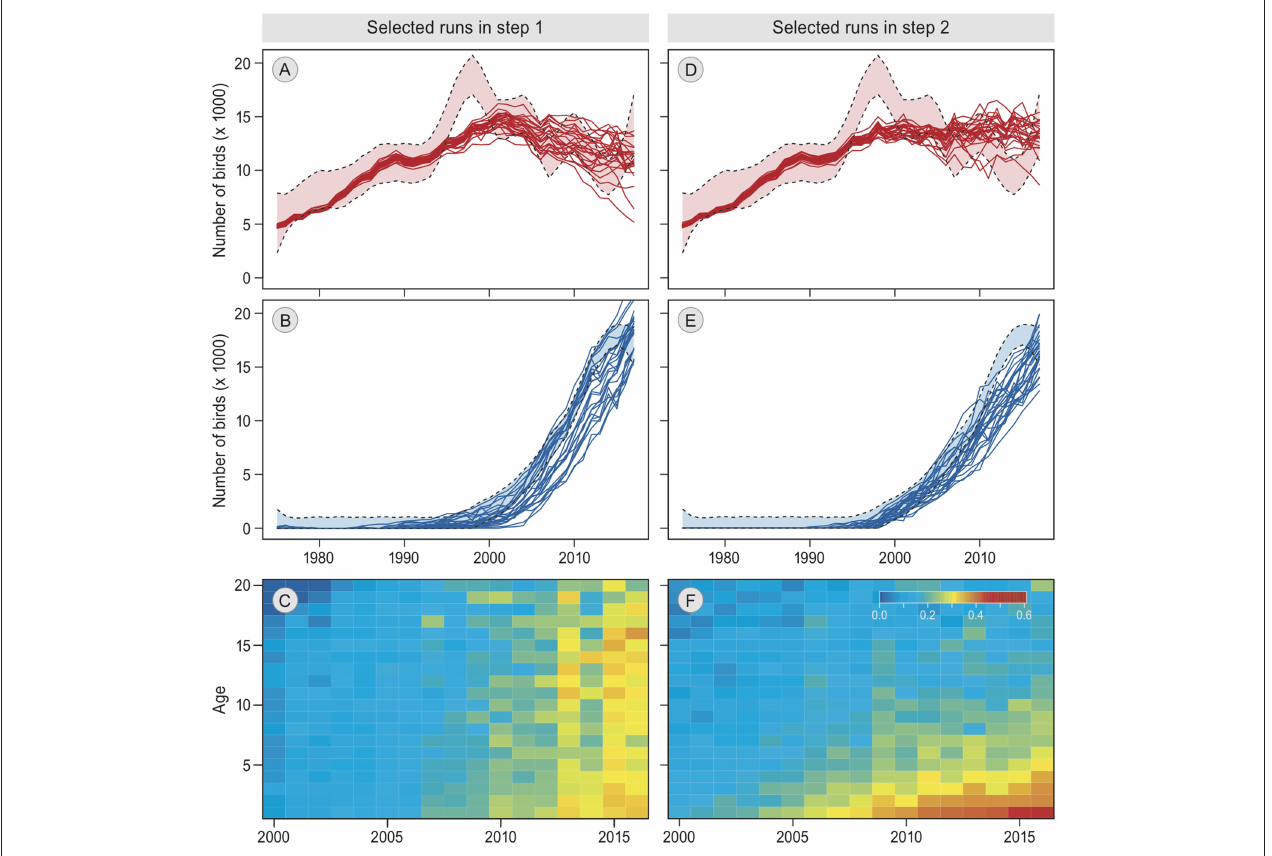
FIGURE 3 | Patterns in best simulation runs. (A,B,D,E) show the annual numbers of barnacle geese staging in Helgeland and Vesterålen, respectively, from 1975 to 2017. The empirical estimates confidence interval ( Tombre et al., 2019) are indicated by the light colors and dashed lines. Solid lines are the 25 best simulation runs. ± (C,F) shows for the single best simulation run the probability of switching from Helgeland to Vesterålen in the next year, by calendar year (2000–2016, x-axis) and by age (0–20, y-axis). The results of the first step in the model selection are on the left (A–C) , the results of the second and final step are on the right (D,E,F)